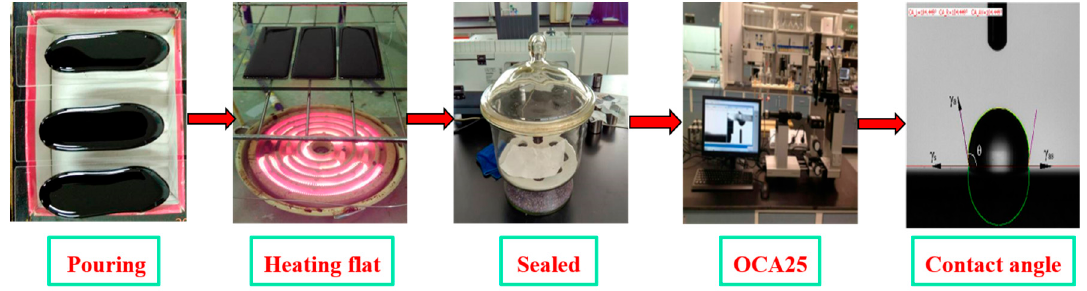
Figure 3. Contact angle preparation and measurement.